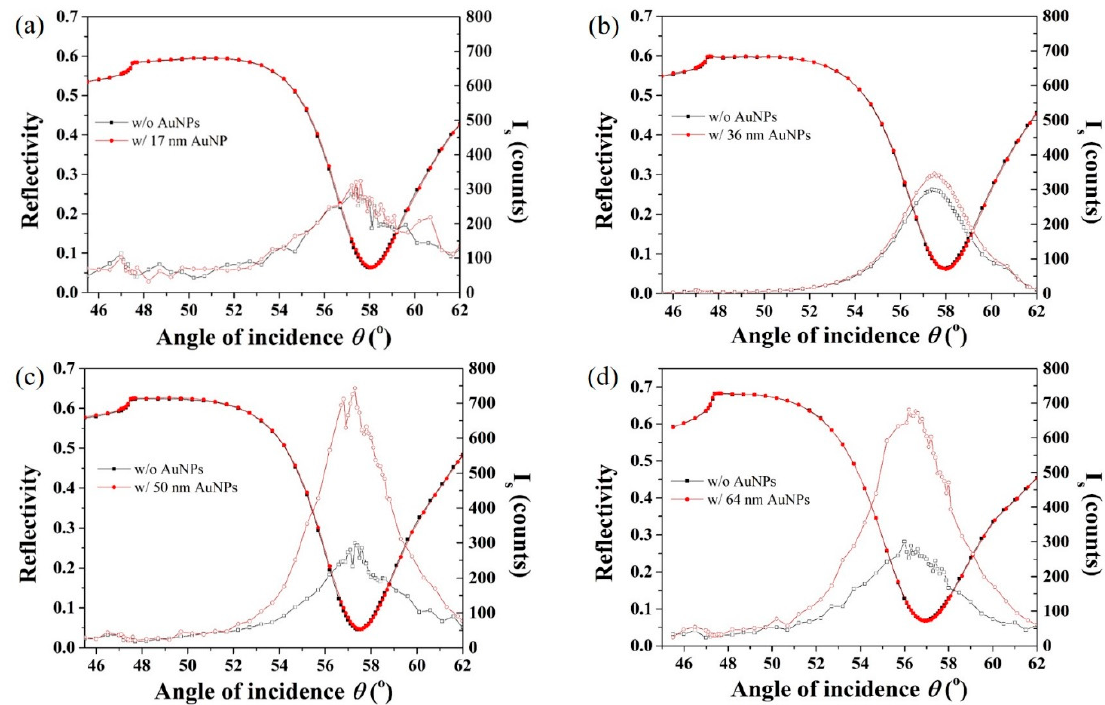
Figure 5. Angular reflectivity and scattering spectra as a function of the angle of incidence with or without the specific adsorption of AuNPs with diameters of ( a ) 17 nm, ( b ) 36 nm, ( c ) 50 nm and ( d ) 64 nm.